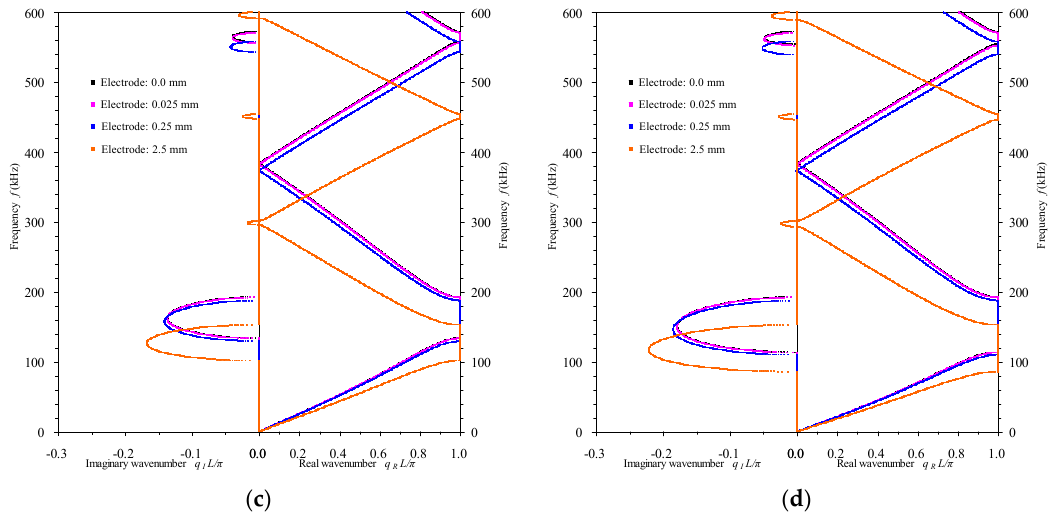
Figure 6. Influence of the electrode’s thickness on the propagation constants spectra of the periodic PZT-5H piezoelectric rod covered by brass electrodes with periodic electrical boundaries: ( a ) electric-open condition; ( b ) applied electric capacity condition with C “ α A { l “ 1.02 ˆ 10 ´ 12 F; ( c ) electric-short condition; and ( d ) applied feedback control condition with K g “ 5 ˆ 10 8 V { m.